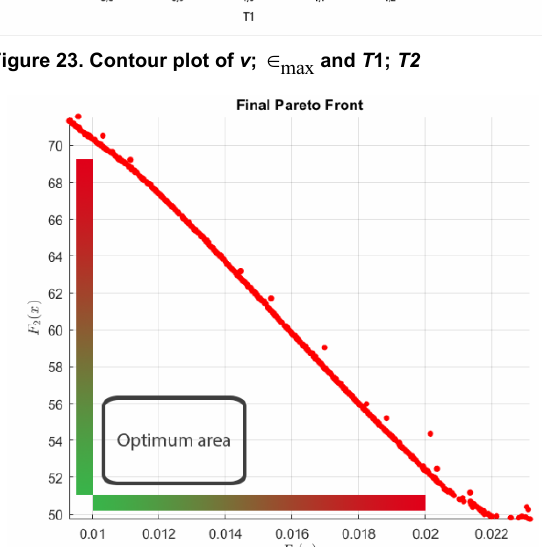
Table 4. Mono-objective optimization